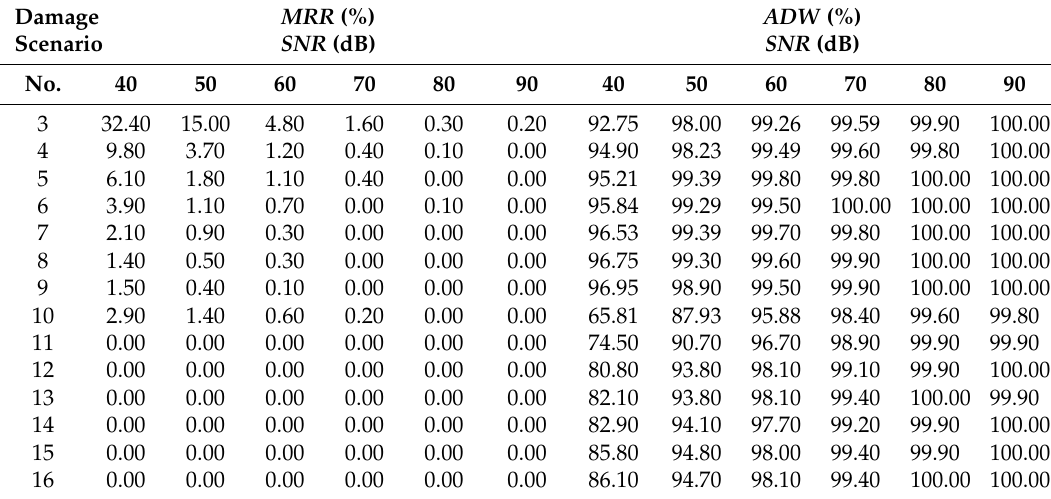
Table 2. Monte Carlo simulation results for different noise